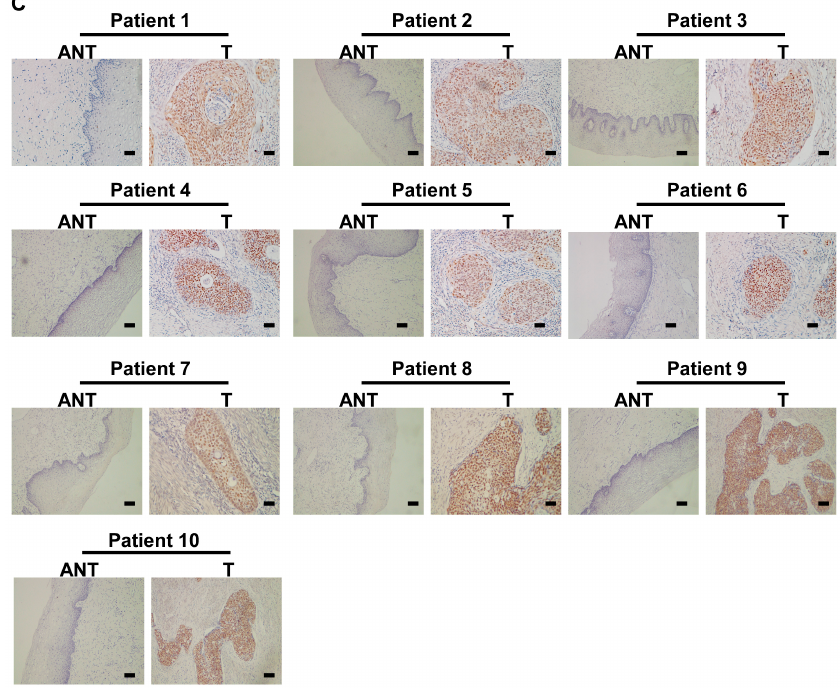
Figure 2. NR2F6 mRNA and protein overexpression in cervical cancer tissues. ( A ) Representative Western blots of NR2F6 protein expression in 10 matched pairs of cervical cancer tissues (T) and adjacent noncancerous tissues (ANT). GAPDH was used as the loading control; ( B ) Real-time PCR quantification of average T/ANT ratios of NR2F6 mRNA expression in paired cervical cancer (T) and adjacent noncancerous tissues (ANT) and normalization against GAPDH. Error bars, standard deviation (SD) of the mean calculated from three parallel experiments; ( C ) Immunohistochemical (IHC) assay of NR2F6 protein expression in 10 pairs of matched cervical cancer tissues. Scale bars = 50 µ m, * p < 0.05.